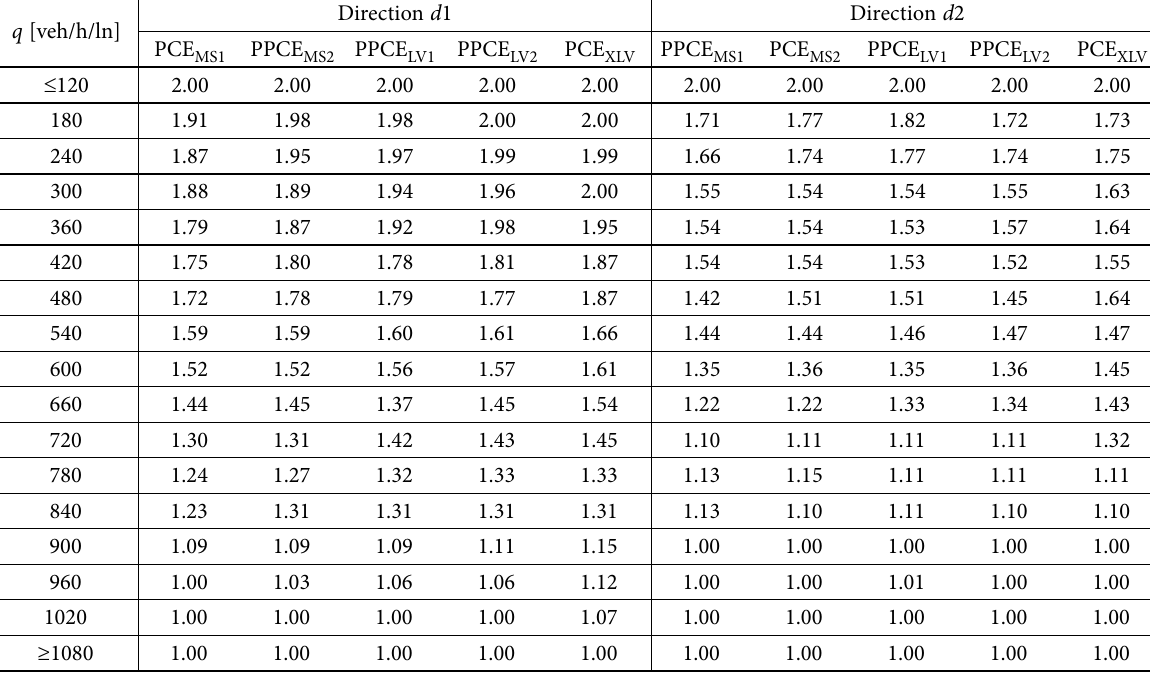
Table 3. PCE for SP30 road, directions d 1 and d